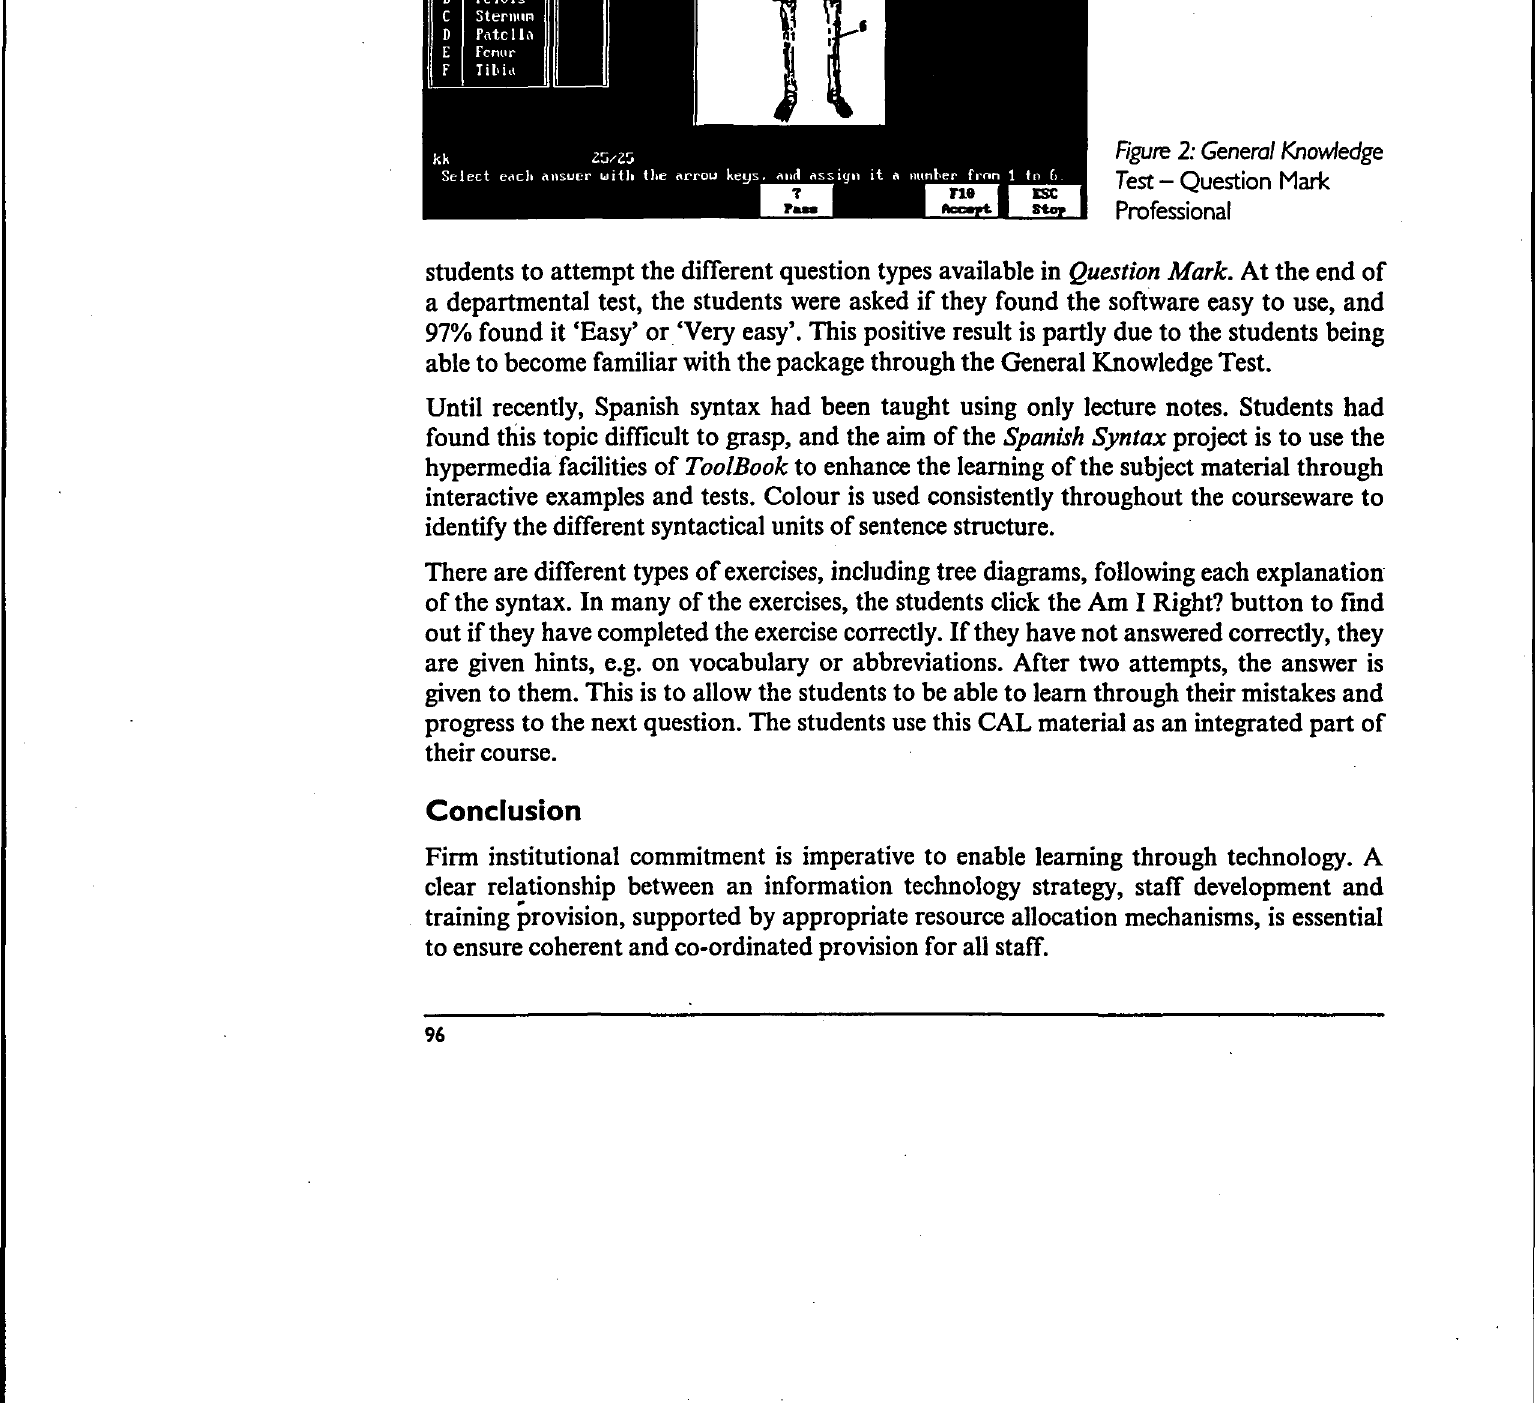
Figure 2: General